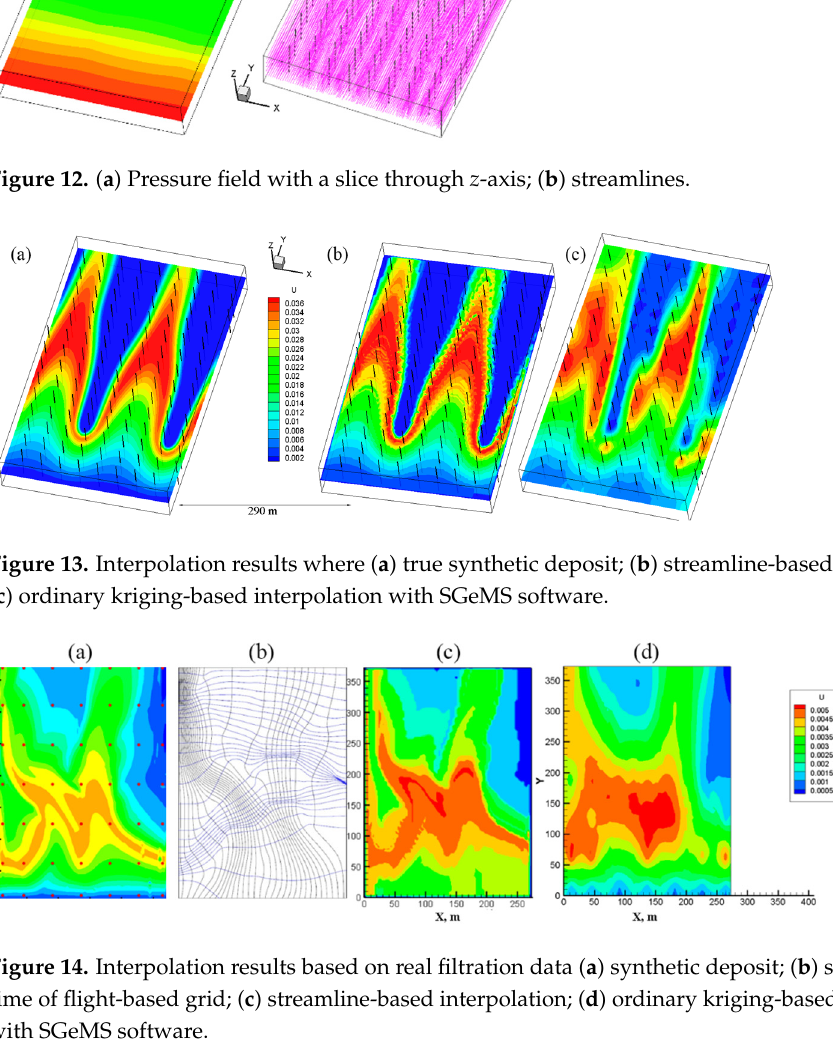
Figure 12. ( a ) Pressure field with a slice through z -axis; ( b ) streamlines.